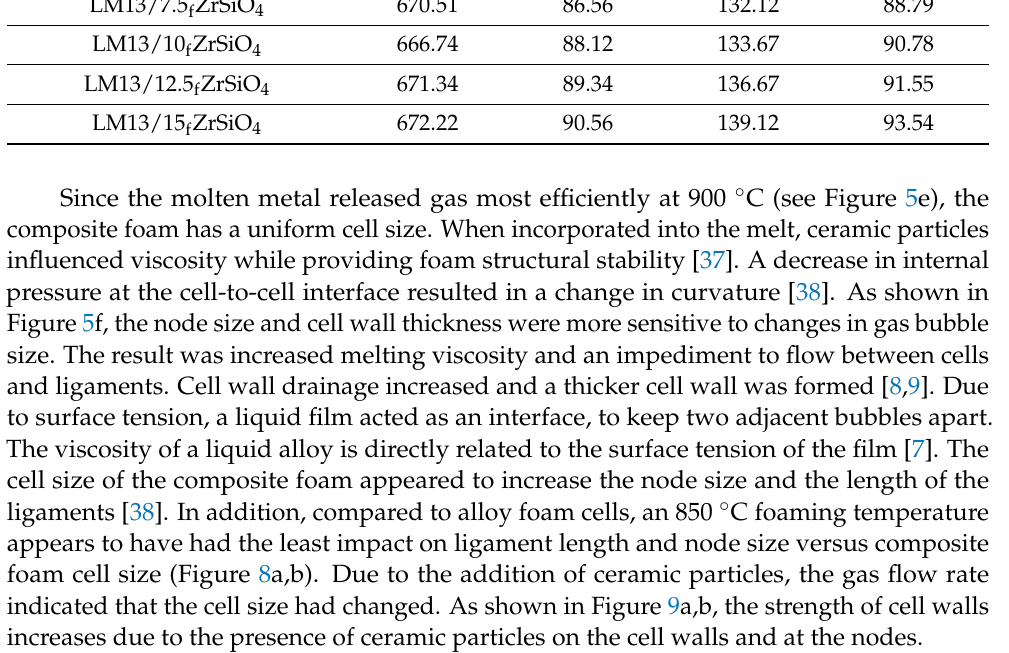
Table 5. Variation in microhardness of LM13 alloy foam and its composite foam different phases of composite foam (subscript ‘f’ shows for fine particles). Microhardness (Hv) LM13 Alloy/Composite Foam At Particle At Matrix At Interface At Node LM13 alloy foam - 69.49 - 69.60 LM13/2.5 f ZrSiO